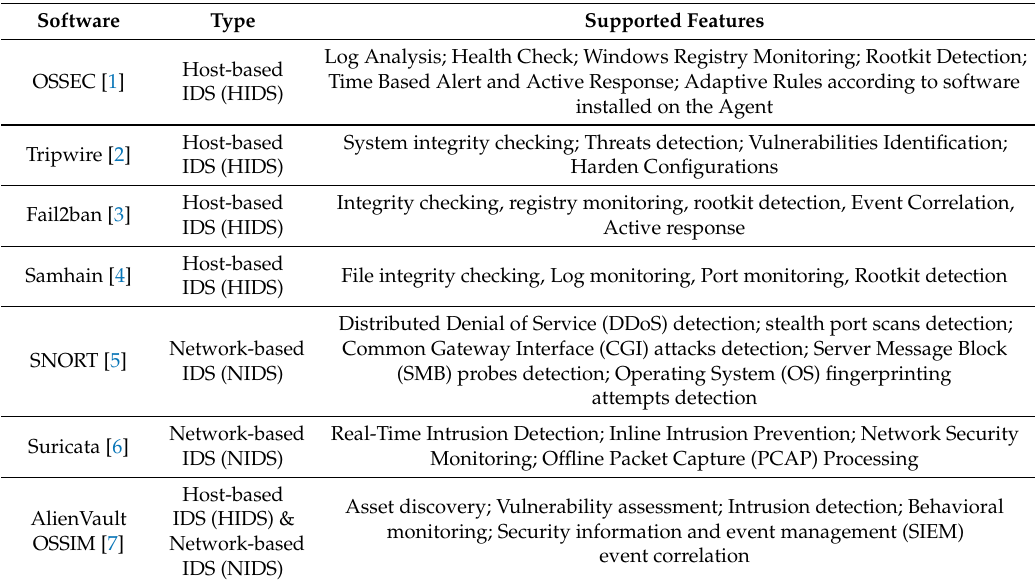
Table 1. Comparison of multiple Intrusion Detection Systems